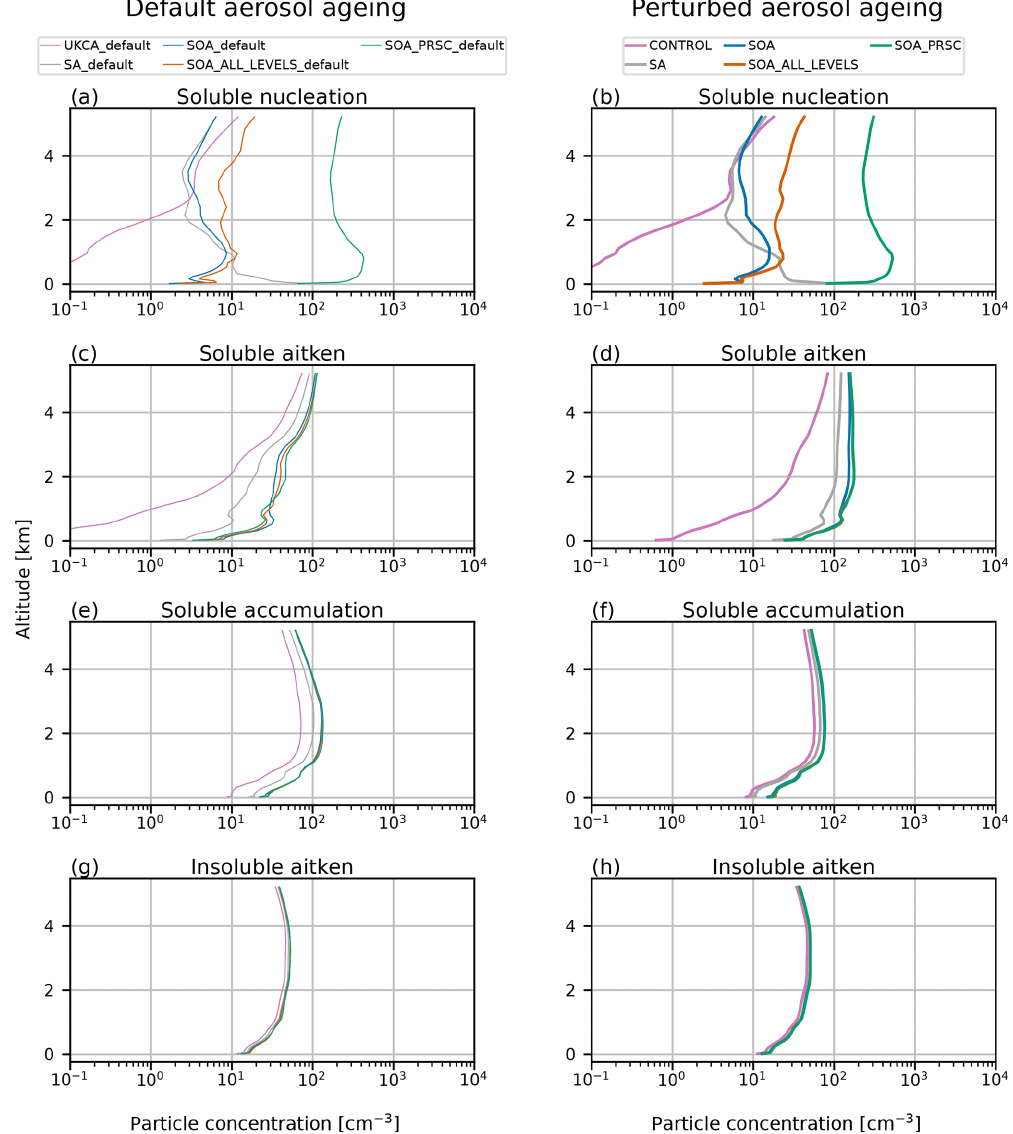
Figure C2. Mean simulated aerosol profiles for AO2018 campaign period. Concentrations shown are for (a–b) soluble nucleation, (c–d) sol- uble Aitken, (e–f) soluble accumulation, and (g–h) insoluble Aitken modes. Model output is from simulations UKCA_DEFAULT and CON- TROL (pink lines), SA_default and SA (grey lines), SOA_ALL_LEVELS_default and SOA_ALL_LEVELS (orange lines), SOA_default and SOA (blue lines), and SOA_PRSC_default and SOA_PRSC (green lines).